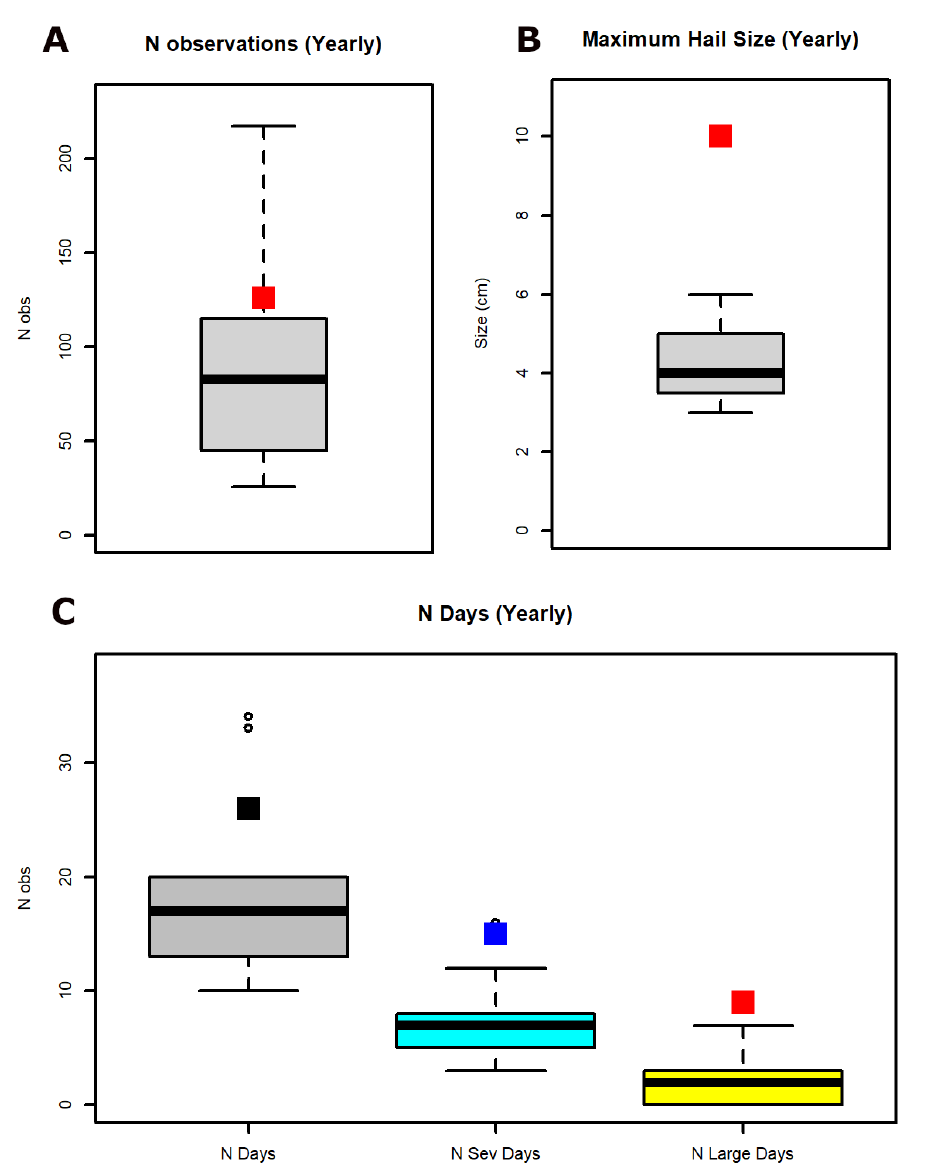
Figure 2. Box plots of the yearly values for the period 2013–2021 of ( A ) the number of observations, ( B ) the maximum hail size recorded, and ( C ) the number of days (from left to right : total, with severe hail, and with very large hail). The squares (red in panels A , B , and black, blue and red in panel C ) indicate the values for the year